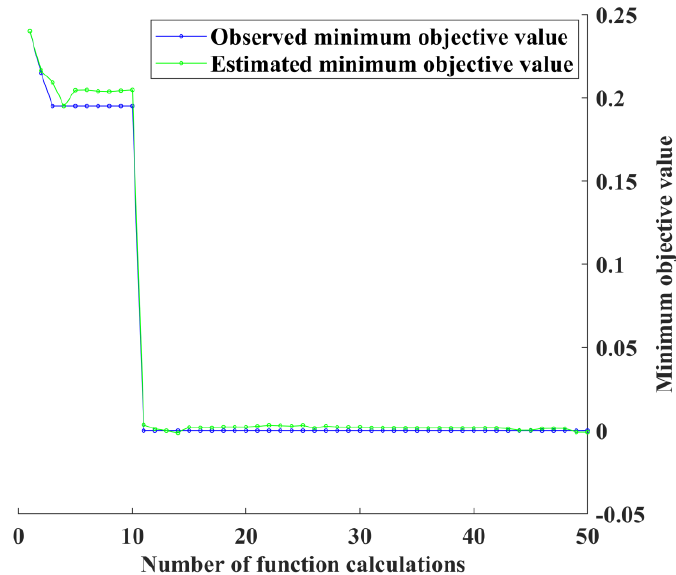
Figure 9. Number of Bayesian optimization.